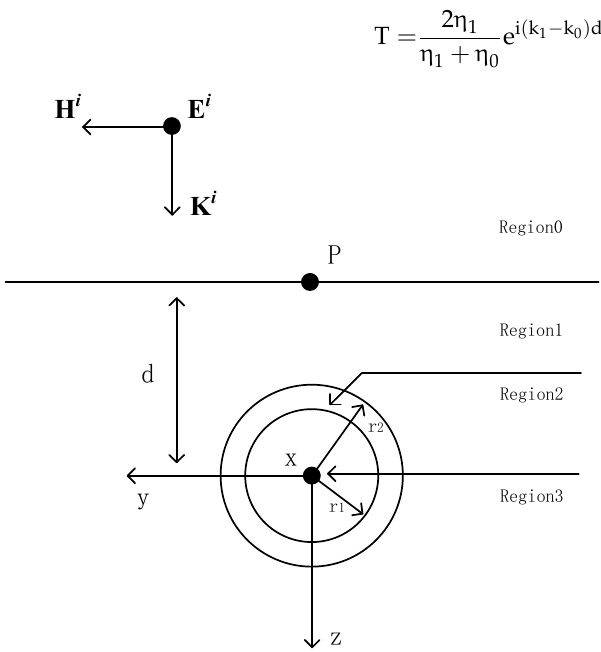
Figure 1. Geometric model of a buried medium-coated conducting sphere.